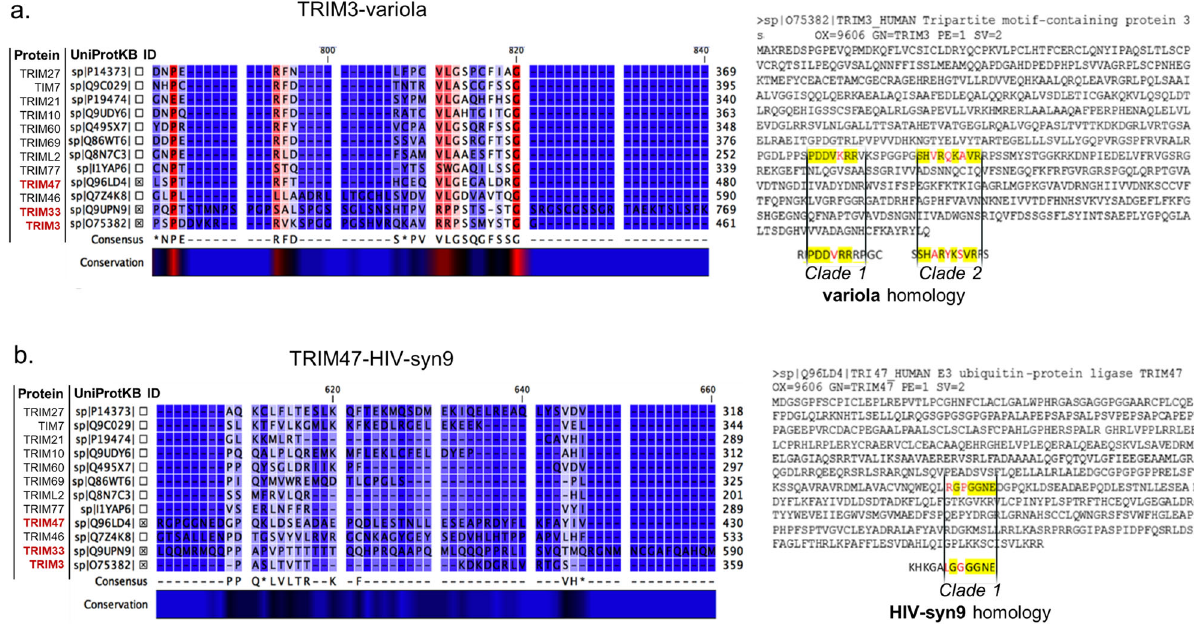
Fig. 7 Partial amino acid alignments of the DM-associated TRIM proteins that share amino acid similarity with viral species. Alignment of all identi fi ed TRIM proteins in DM (Fig. 5a); TRIM3 is located on the bottom of the alignments plots. Above TRIM3 (sp|O75382) are TRIM33 (sp|Q9UPN9) and TRIM47 (sp|Q96LD4); cross-marked. Conservation level is presented as a colour gradient (high; red, low; blue). a Partial alignment of the region where the TRIM3- Variola high similarity epitopes were identi fi ed. The TRIM3 protein sequence is presented next to the alignment plot. Yellow: the two TRIM3 epitopes with high amino acid (AA) similarity to Variola and poxviruses (Fig. 6). Black font: identical AAs between TRIM3 and Variola virus. Red font; different AAs between TRIM3 and Variola virus. Both epitopes are located only 6 AAs apart (relative to TRIM3 protein sequence). TRIM3 presents high similarity with TRIM33 in respect to the speci fi c AA epitopes. b Partial alignment of the region where the TRIM47- HIV - syn9 high similarity epitope was identi fi ed. The TRIM47 protein sequence is presented next to the alignment plot. Yellow: the TRIM47 epitopes with high AA similarity to HIV and syn9 phage (Supplementary Fig. 7d). Black font: identical AAs amongst TRIM47 and the two viruses. Red font; different AAs amongst TRIM47 and the two viruses. The epitope is poorly conserved amongst the DM-speci fi c TRIM